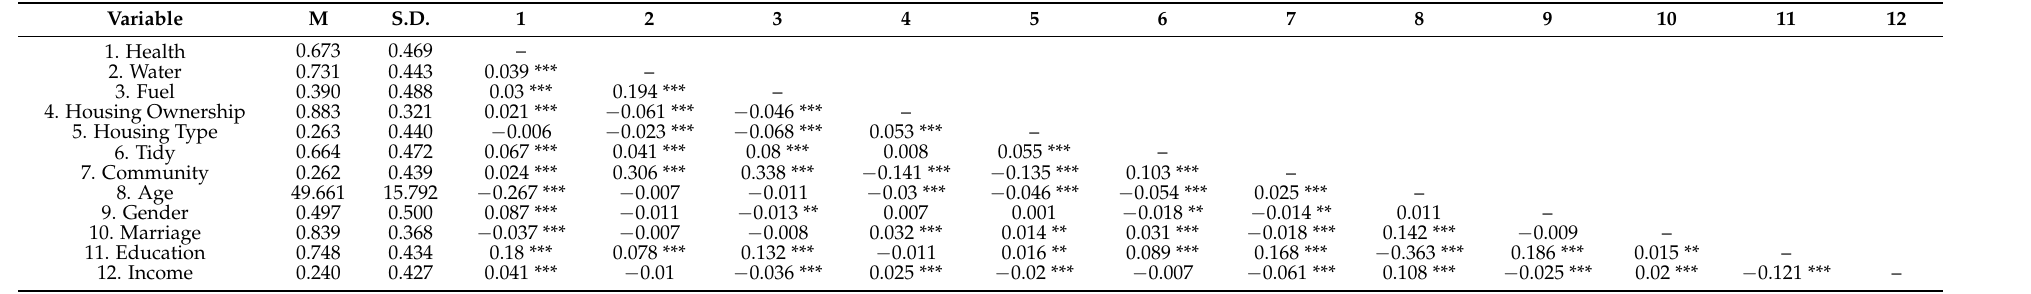
Table A1. Descriptive statistics and correlation of